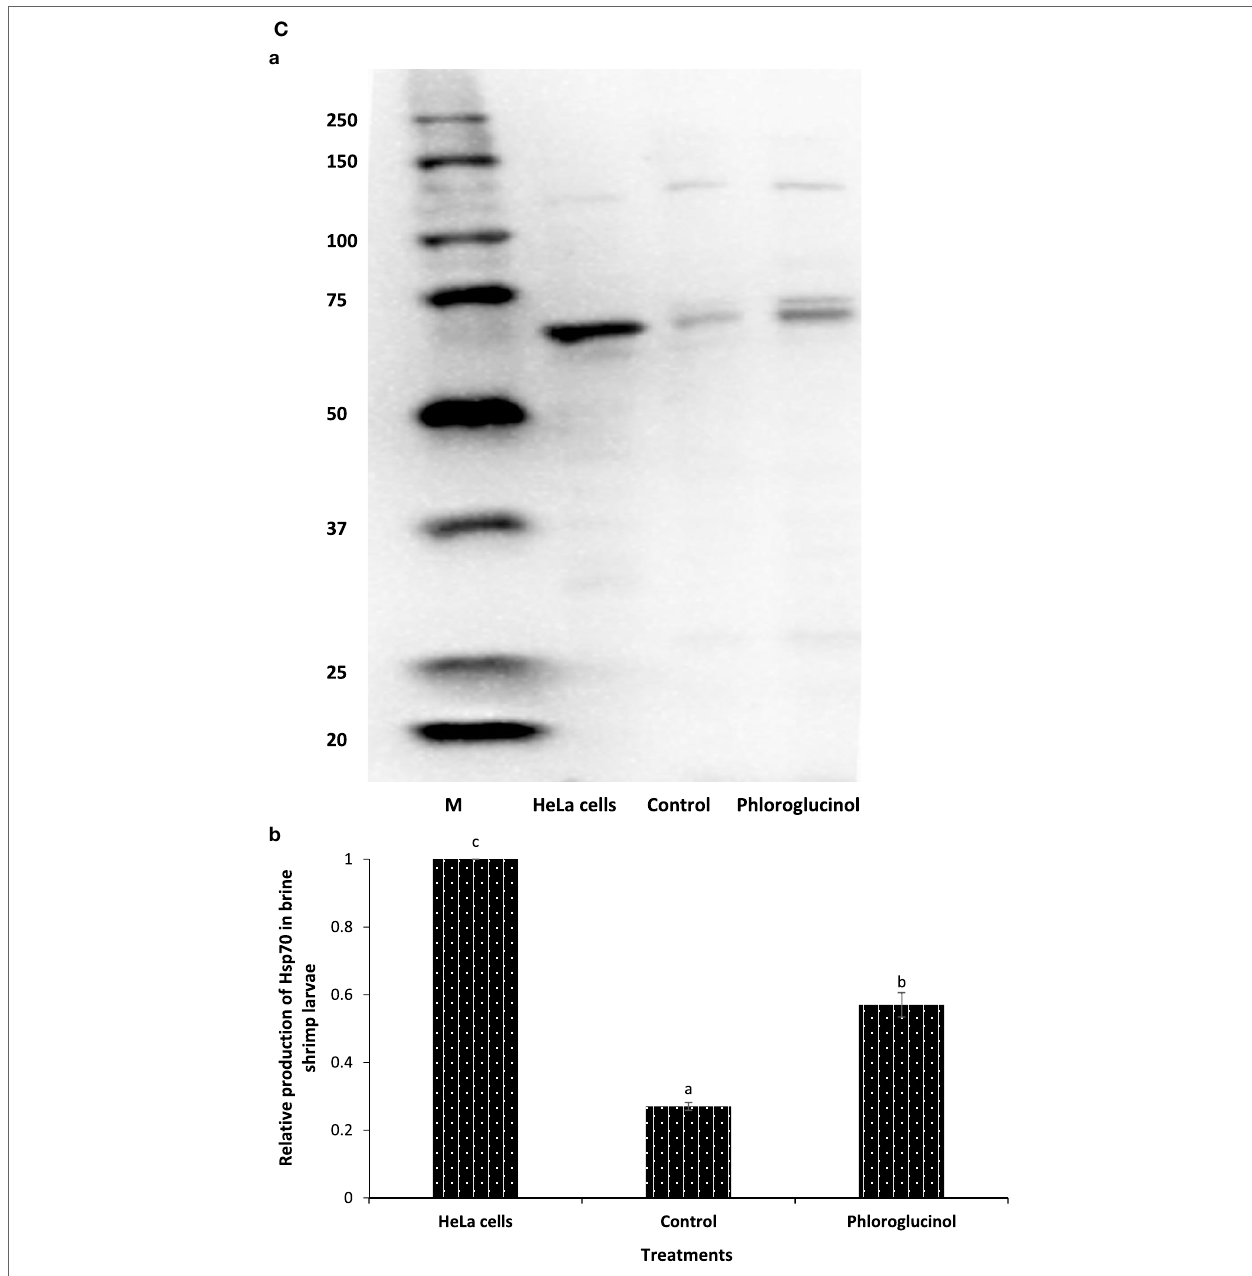
FigUre 1 | Phloroglucinol pretreatment of axenic brine shrimp larvae protects them against subsequent Vibrio parahaemolyticus challenge and is associated with heat shock protein (Hsp70) induction. (a) Survival (%) of phloroglucinol-pretreated brine shrimp larvae after 48 h of challenge with V. parahaemolyticus MO904. The larvae were pretreated with phloroglucinol at the indicated doses for 2 h, rinsed to wash away the compound, and then allowed to recover for 2 h. The larvae were subsequently challenged with V. parahaemolyticus at 10 7 cells/ml of rearing water. Non-pretreated larvae that were either challenged with V. parahaemolyticus (positive control) or unchallenged (negative control) served as controls. Error bars represent the standard error of five replicates; different letters indicate significant differences ( P < 0.001). (b) Toxicity of phloroglucinol to gnotobiotic brine shrimp larvae. The larvae were pretreated with phloroglucinol at the indicated doses for 2 h, rinsed to wash away the compound, and then allowed to recover for 2 h. Non-pretreated larvae served as negative controls. Survival was recorded 48 h after the recovery period. Error bars represent the standard error of five replicates; different letters indicate significant differences ( P < 0.001). (c) Induction of Hsp70 protein in brine shrimp larvae pretreated with phloroglucinol (30 µM). Non-pretreated larvae were maintained as control. (a) Protein extracted from control and treatment groups was resolved on an SDS-PAGE gel and then transferred to a polyvinylidene fluoride membrane and probed with an antibody to brine shrimp Hsp70. Molecular mass standards (M) in kilodaltons (protein ladder) are shown on the left. The induction of Hsp70 in HeLa cells was regarded as 1. (b) Quantitative analysis of Hsp70 levels in brine shrimp larvae is presented relative to Hsp70 production in HeLa cells. Error bars represent the standard error of three replicates; different letters indicate significant differences ( P <